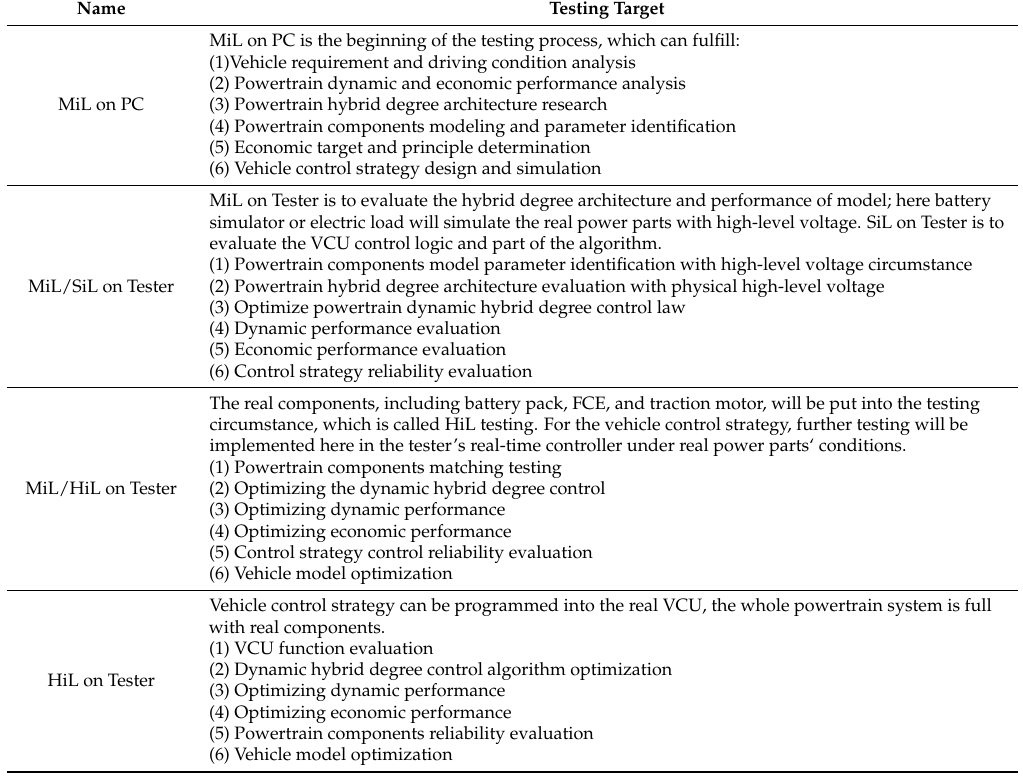
Table 1. Testing target of hybrid degree testing based on XiL